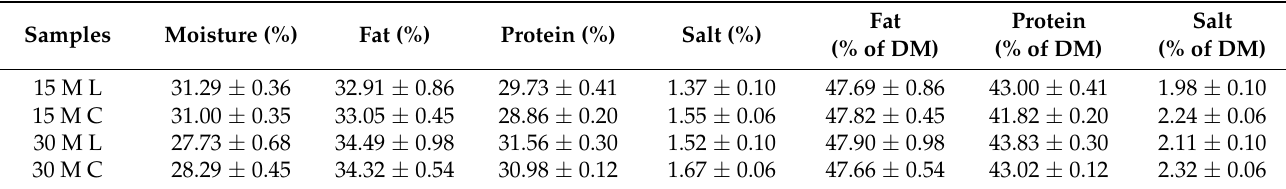
Table 2. Compositional analysis of different cheese groups.